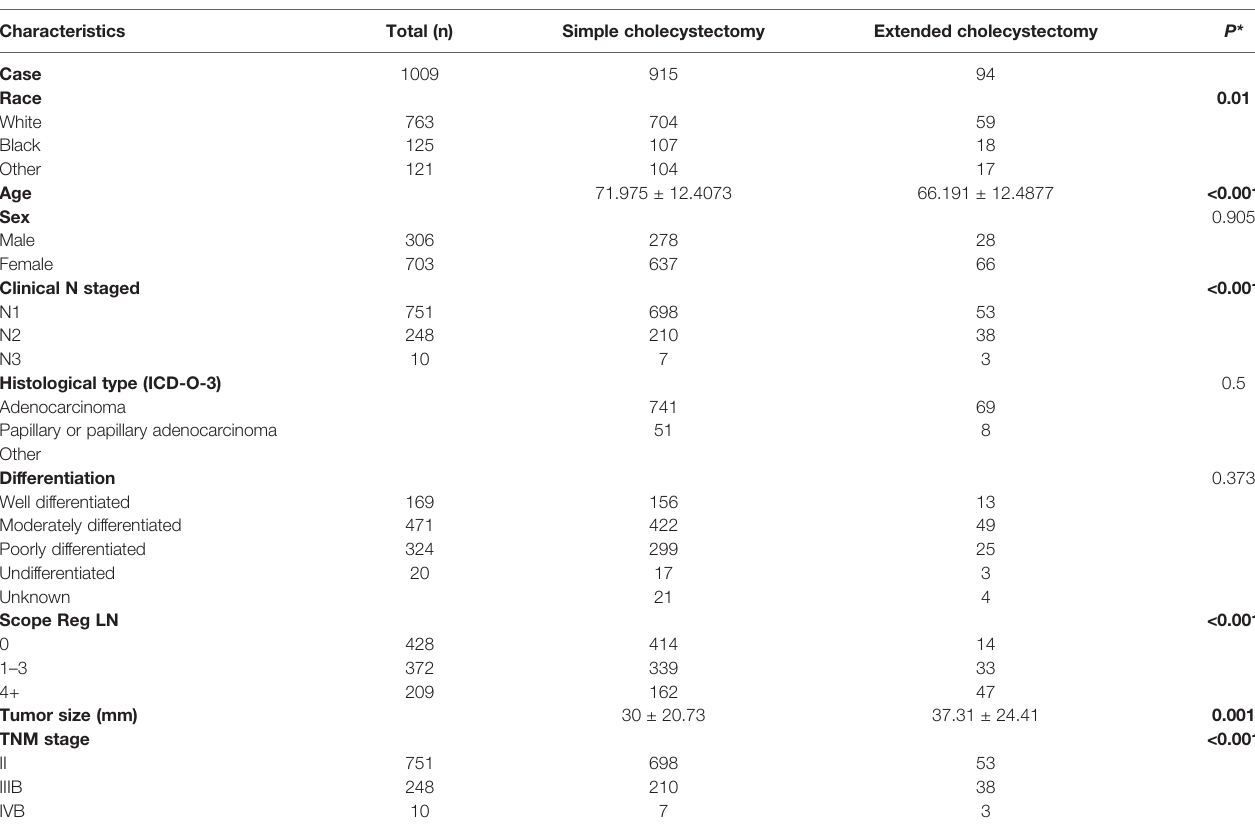
TABLE 1 | Patient baseline characteristics before propensity score